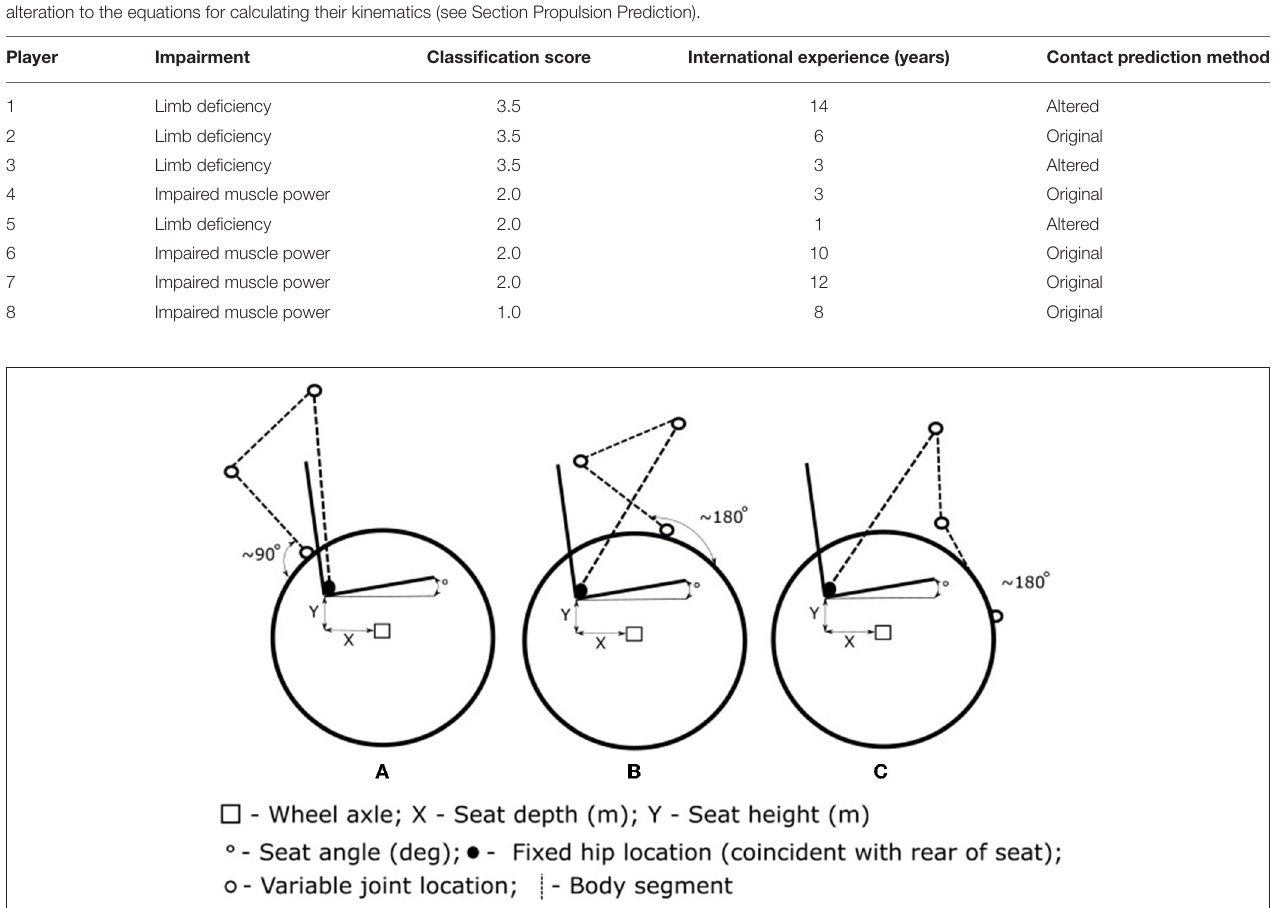
FIGURE 1 | The propulsion model consisted of a trunk, upper arm, and forearm segments with a fixed hip position and variable seat height [the vertical distance from the rear of the seat to main (rear) wheel axle], seat depth [often referred to as fore-aft position, the horizontal distance from rear of the seat to main (rear) wheel axle], and seat angle (angle of the seat above the horizontal). Contact angle estimation varied between the previous assumption of the forearm being perpendicular to the wheel tangent at contact (A) , and an altered propulsion method where the forearm is close to parallel with the wheel tangent (B) at contact (Leary et al., 2012) for the added assumption. Release angle (C) is also presented for comparison with the contact positions, with assumption that release occurs when the forearm is parallel to the wheel tangent when the trunk is in its most flexed position. The propulsion kinematic angles (contact and release) are measured with respect to the location about top dead center of the wheel. The hip position visually presented here does not intend to represent the actual hip position for athletes in wheelchair rugby, with the model assuming that hip location is coincident with the rear corner of the